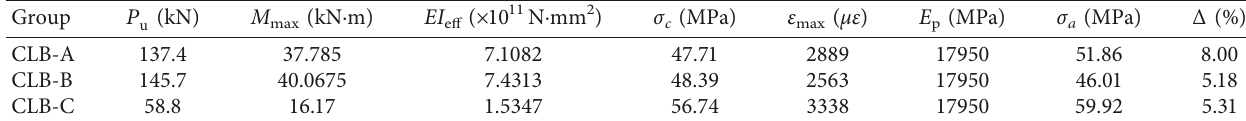
Table 7: Validation of the analytical method of calculating the flexural load-carrying capacity.